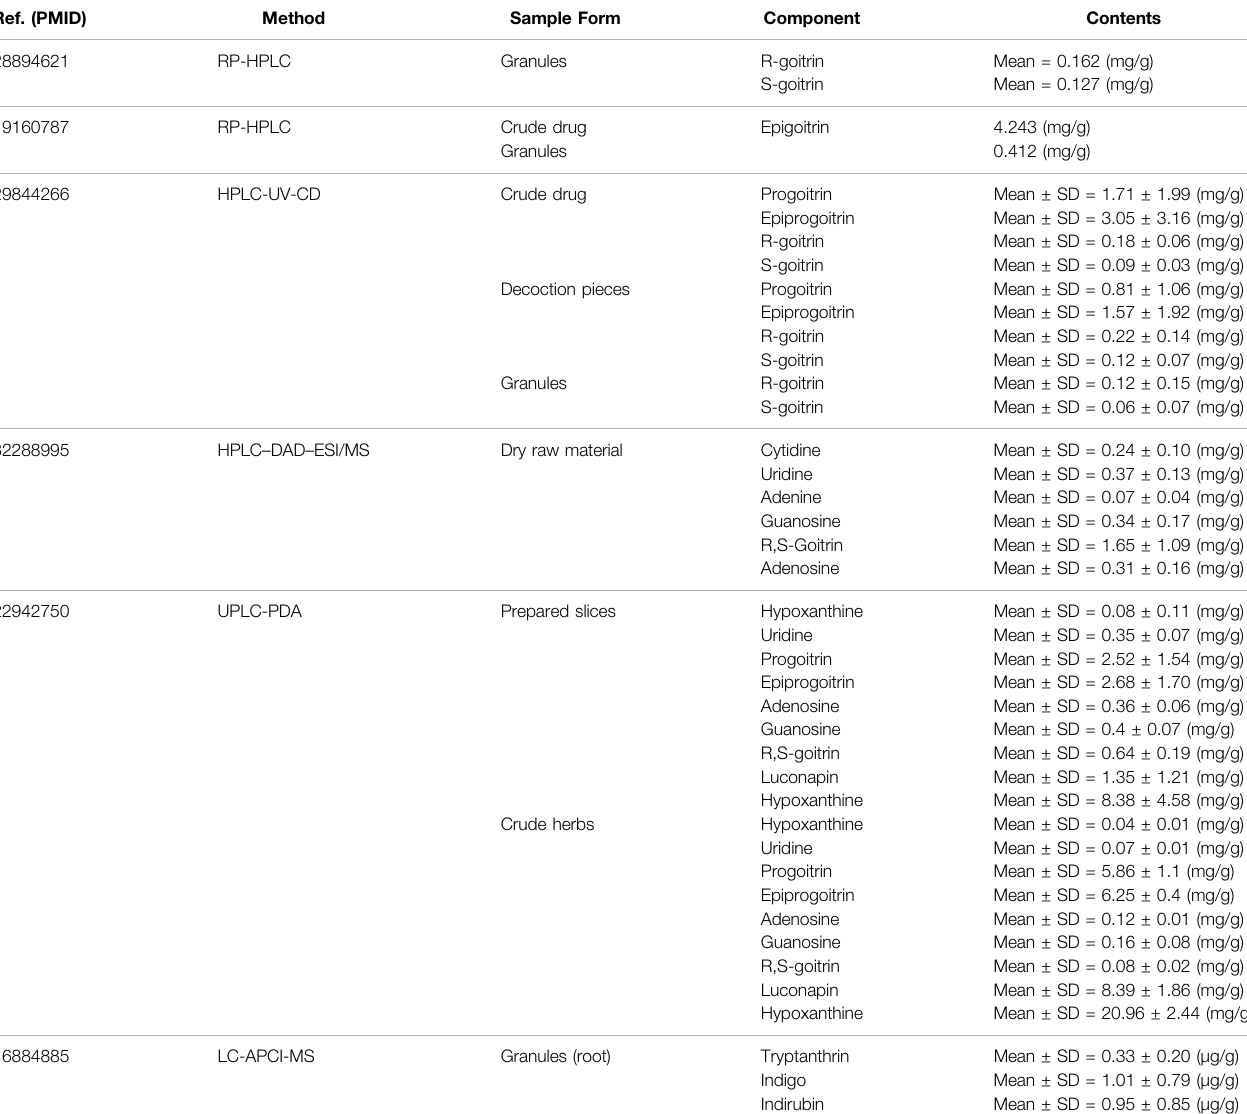
TABLE 1 | Information on the chemical analysis using the high-performance liquid chromatography (HPLC) method for the herb Isatis tinctoria L. (Banlangen, BLG). Ref.